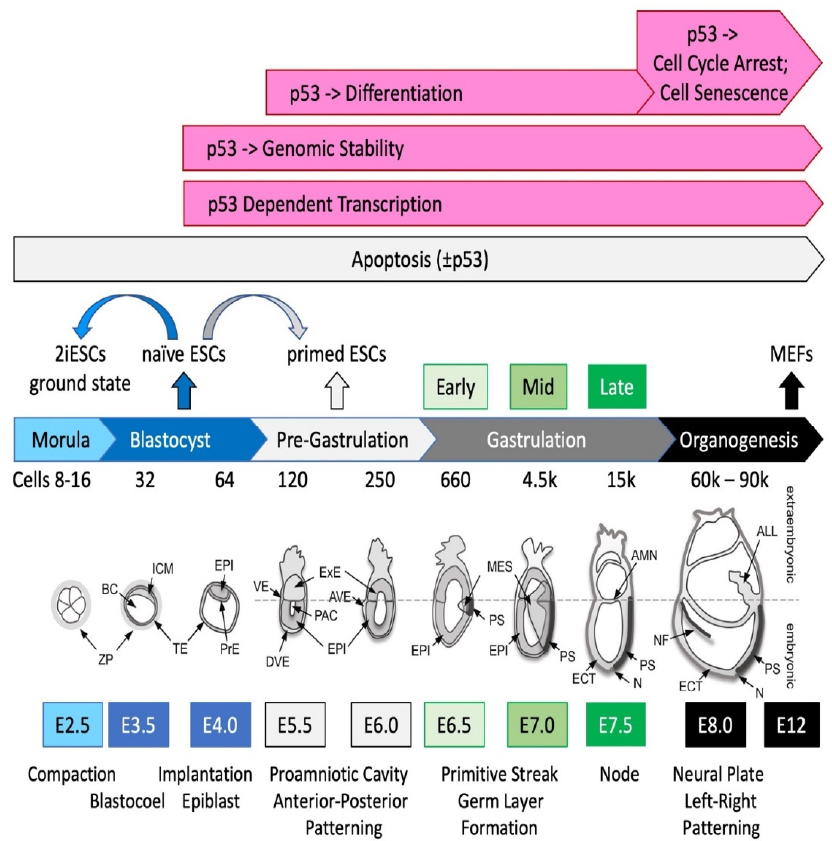
Figure 2. Preimplantation and early post-implantation mouse development . The p53 transcription factor and tumor suppressor protein is not essential for mammalian embryonic development, although it does facilitate several important events beginning with maintaining genomic stability by preventing polyploidy and aneuploidy during self-renewal of pluripotent embryonic stem cells (ESCs). Self-renewal refers to the ability of pluripotent stem cells to undergo an indefinite number of cell divisions without losing their ability to differentiate into cells derived from all three primary germ layers. In ESCs, p53 facilitates differentiation during gastrulation, although it is not required for either transient cell cycle arrest or induction of apoptosis in response to DNA damage. In mouse embryonic fibroblasts (MEFs), DNA damage induces either p53 -facilitated transient cell cycle arrest or cell senescence. The range or average number of cells for the entire conceptus (embryonic days post-coitum E0.5-E4.5) or the epiblast and the germ layers (E5.5-E8.0), and the key morphogenetic events at each age are indicated. Abbreviations: ALL (allantois), AMN (amnion), AVE (anterior visceral endoderm), BC (blastocyst cavity), DVE (distal visceral endoderm), ECT (ectoderm), EPI (epiblast), ExE (extraembryonic ectoderm), ICM (inner cell mass), MES (mesoderm), N (node), NF (neural fold), PAC (proamniotic cavity), PrE (primitive endoderm), PS (primitive streak), TE (tro- phectoderm), VE (visceral endoderm), ZP (zona pellucida). Adapted from [36] with permission from Placenta journal,